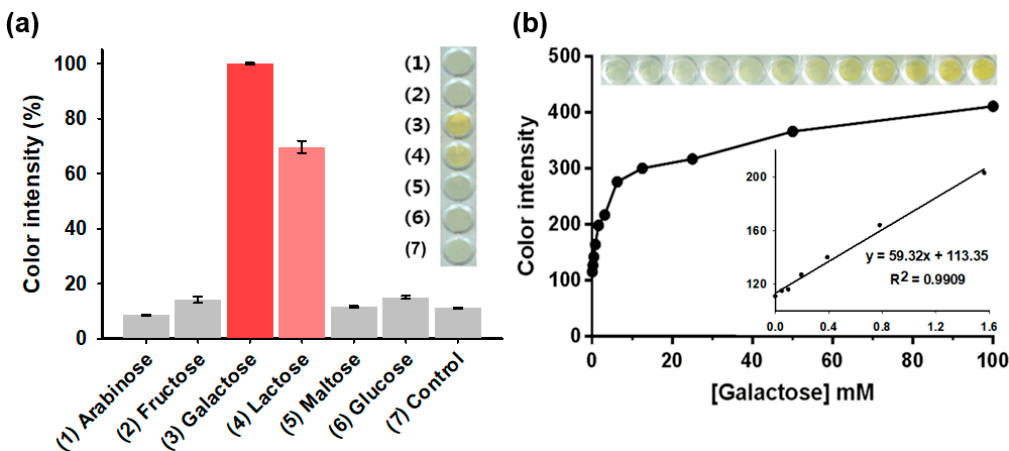
Figure 5. ( a ) Real images of the selective colorimetric detection of galactose using the agarose composite entrapping nanoceria and Gal Ox with the corresponding color intensities. A 5 mM concentration of galactose and lactose was used, while 50 mM of other carbohydrates was used in the experiments. ( b ) A dose-response curve, real images, and the corresponding linear calibration plots for galactose determination using the composite entrapping nanoceria and Gal Ox. Each error bar represents the standard deviation of three independent measurements.